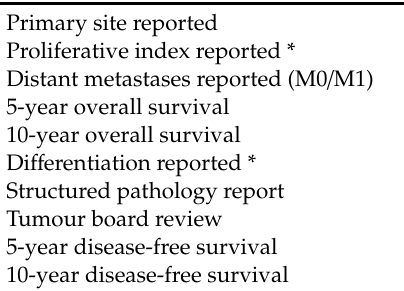
Table 2. Final consensus-derived NET